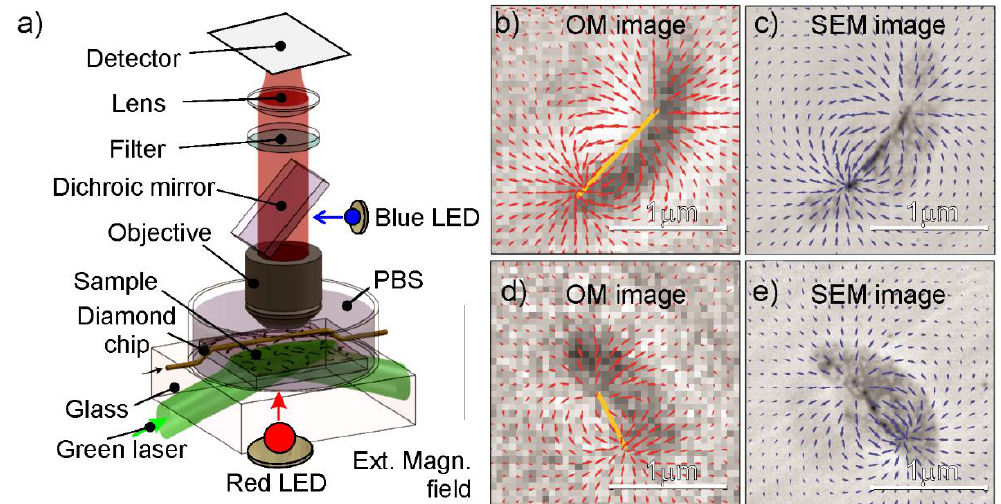
Figure 18. ( a ) Representation of the wide-field magnetic imaging microscope field fluorescence microscope setup vector plots of the measured (red arrows, left panel) and simulated (blue arrows, right panel) magnetic field projections in the xy plane are reported superimposed; ( b , d ) optical and ( c , e ) backscattered electron (BSE) images, respectively. Adapted from: [123], published by Nature Publishing Group, 2013.